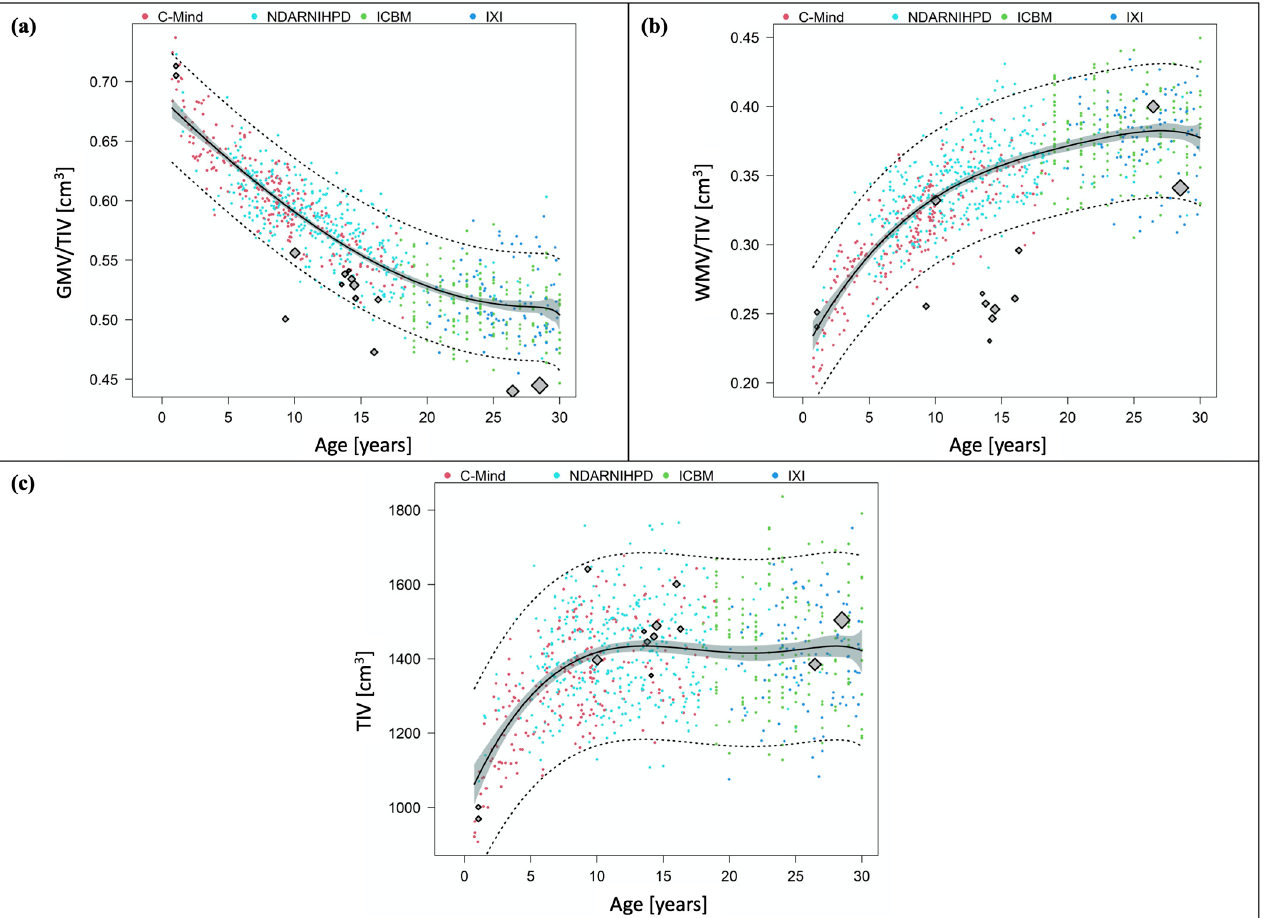
Figure 3. Relative grey and white matter volumes, and total intracranial volume after preterm birth compared to full-term controls. The four different datasets on FT controls are illustrated in different colors. C-MIND is presented in red, NDAR- NIHPD in in cyan, ICBM in green, and IXI in blue. Data points from the PT studies are included as diamonds. The size of each diamond is proportional to the sample size of the study. ( a ) Relative GMV after PT birth compared to FT controls. The graph shows GMV/TIV extracted from the PT studies contrasted against the GMV/TIV trajectory of FT controls with 95%-CI (grey areas) and 95%-PI (dotted lines). ( b ) Relative WMV after PT birth compared to FT controls. The graph shows WMV/TIV extracted from the PT studies contrasted against the WMV/TIV trajectory of FT controls with 95%-CI (grey areas) and 95%-PI (dotted lines). ( c ) TIV after PT birth compared to FT controls. The graph shows mean TIV extracted from the PT studies contrasted against the TIV trajectory of FT controls with 95%-CI (grey areas) and 95%-PI (dotted lines).